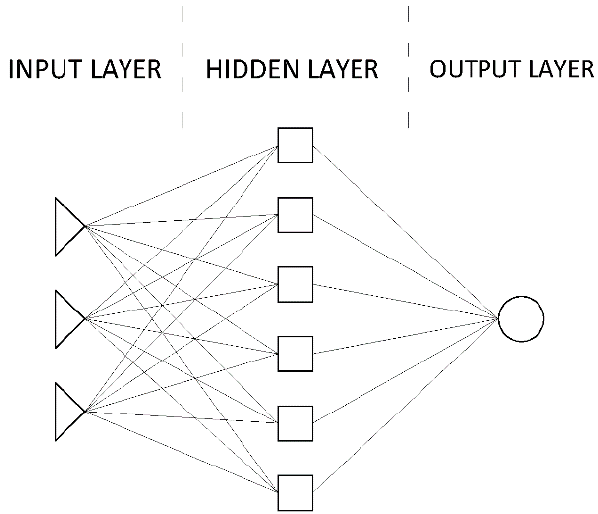
Figure 10. Exemplary ANN (multi-layer perceptron, MLP) with 3 input nodes, 6 nodes in one hidden layer, 1 output node. The ANN of this architecture is marked as (3-6-1).